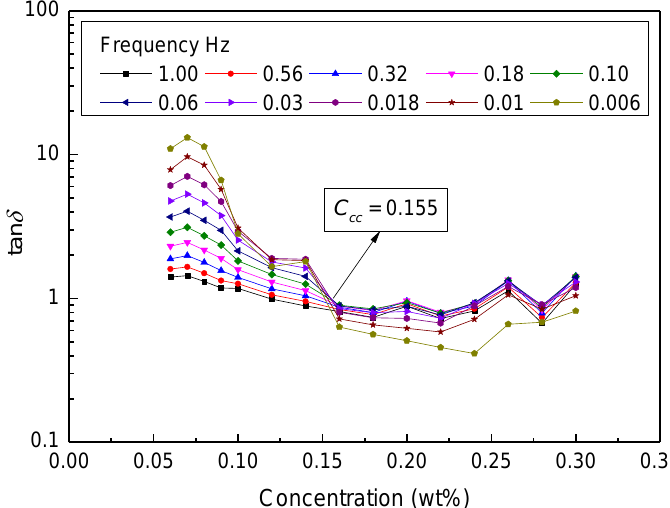
Figure 9. The crosslinking mechanisms between HELV and sodium dodecyl sulfate (SDS). Abbreviations: AMBS, 4-isopropenylcarbamoyl-benzene sulfonic acid.